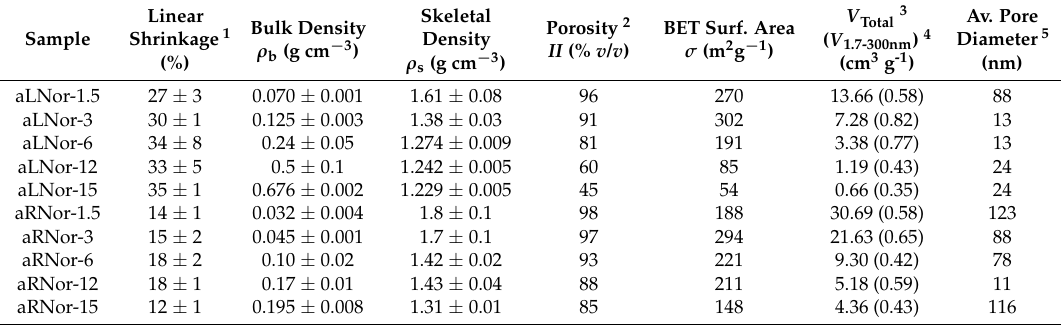
Table 6. Properties of polymer aerogels aLNor-xx and aR-Nor-xx fabricated from the aliphatic (aL-9-NBE) and the aromatic (aR-9-NBE) monomer, respectively.